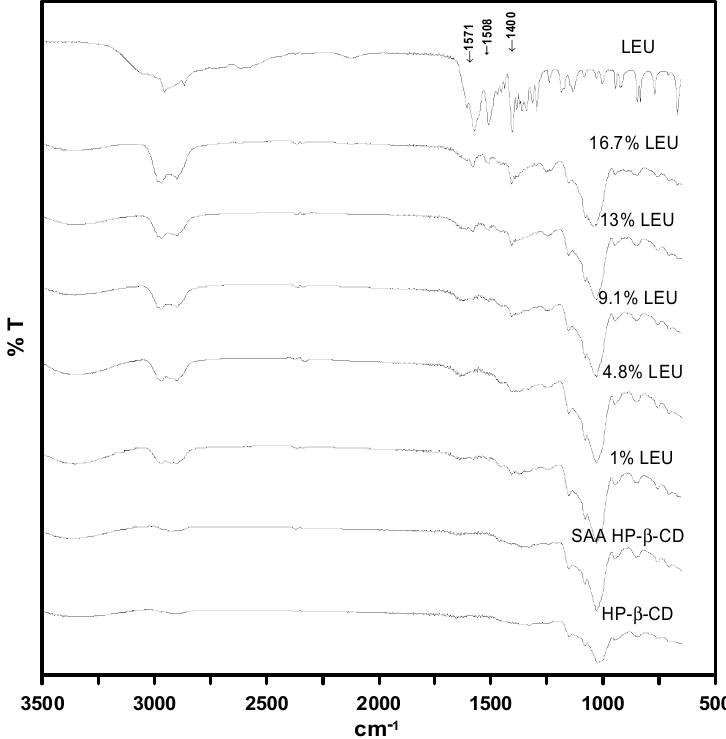
Figure 8. FTIR analysis spectra of the HP- β -CD carrier particles with varying amount of LEU (mass%) produced through